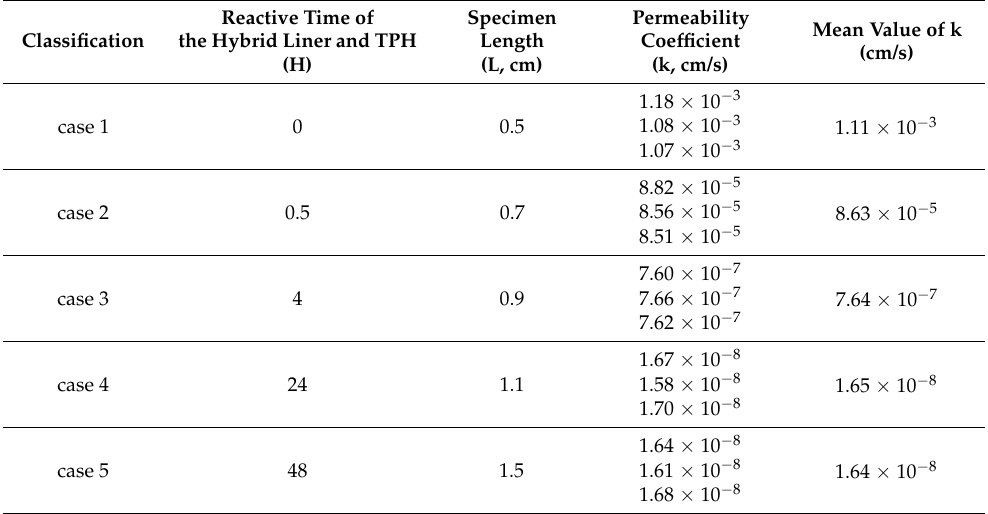
Figure 5. Variation of the permeability coefficient of the hybrid liner by reactive time of TPH. Table 4. Permeability coefficient of the hybrid